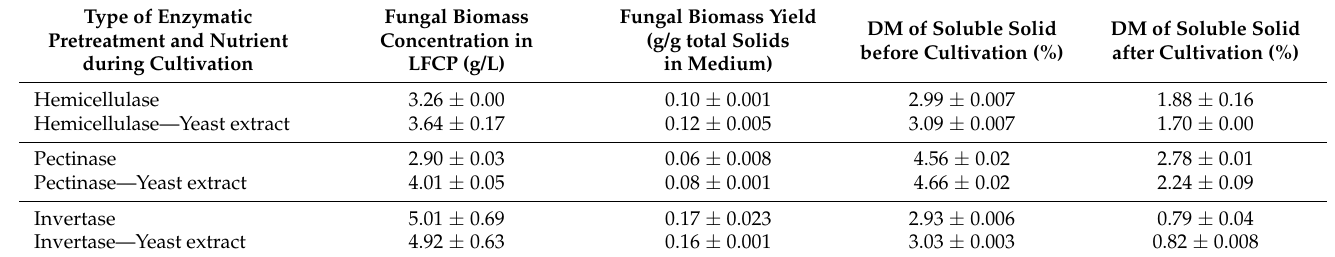
Table 4. Substrate consumption as well as the fungal biomass concentration and yield obtained during the fungal cultivation in bench-scale